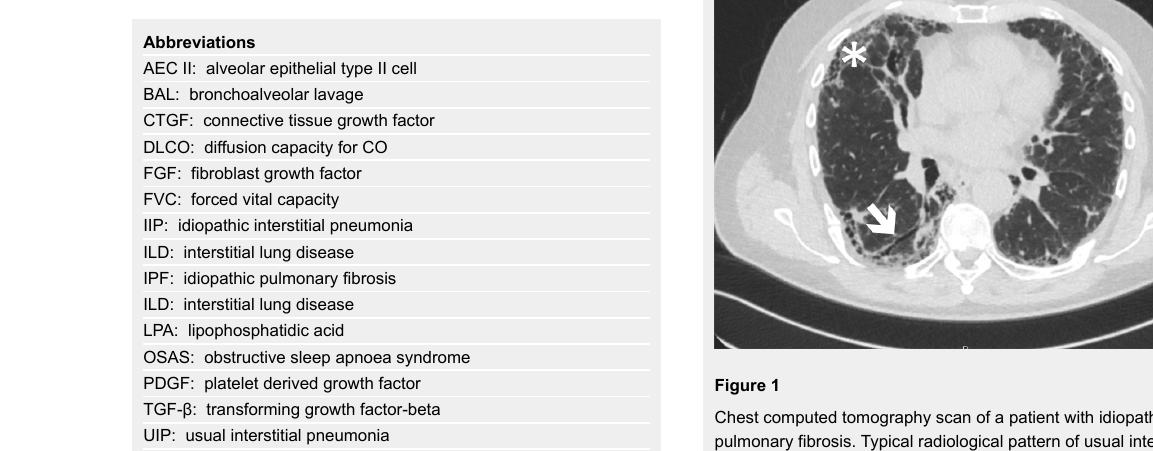
Chest computed tomography scan of a patient with idiopathic pulmonary fibrosis. Typical radiological pattern of usual interstitial pneumonia with traction bronchiectasis (arrow) and subpleural honeycombing (star) is